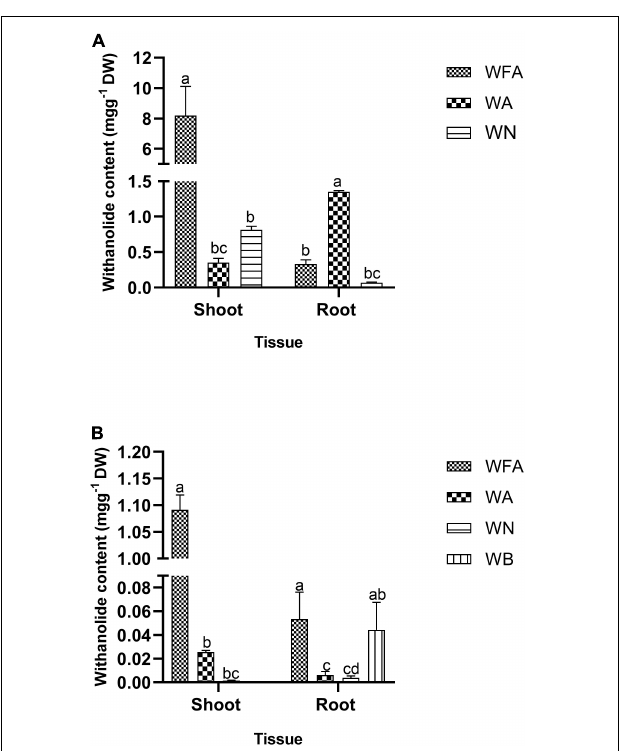
FIGURE 7 | Withanolide content (mg g − 1 DW) of Withania somnifera . (A) RP and (B) VP. Mean values within a column having the same alphabet are not significantly different ( p = 0.05) according to Duncan’s multiple range test (DMRT) ( n = 3).